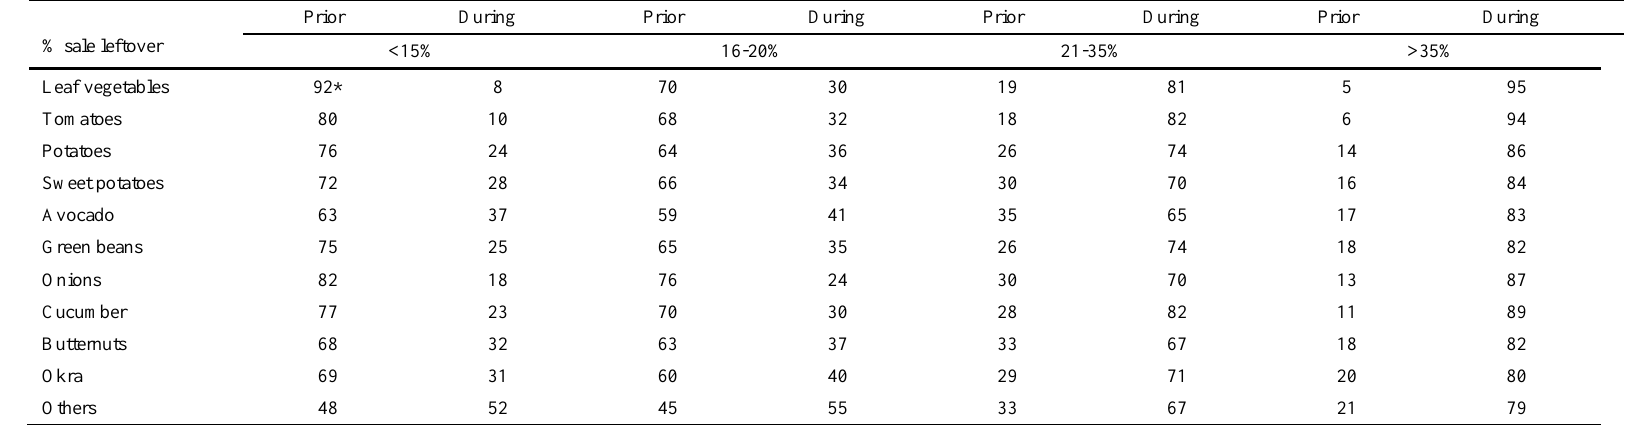
Table 3. Results* for the horticultural produce sales leftover at the markets prior and during the lockdown (n=300). Prior During